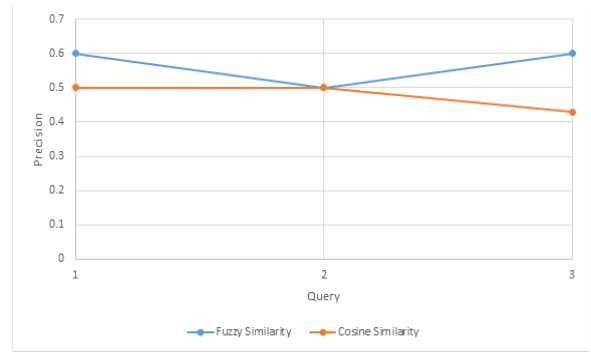
Figure 9 . Comparison of average Precision-Query Curve